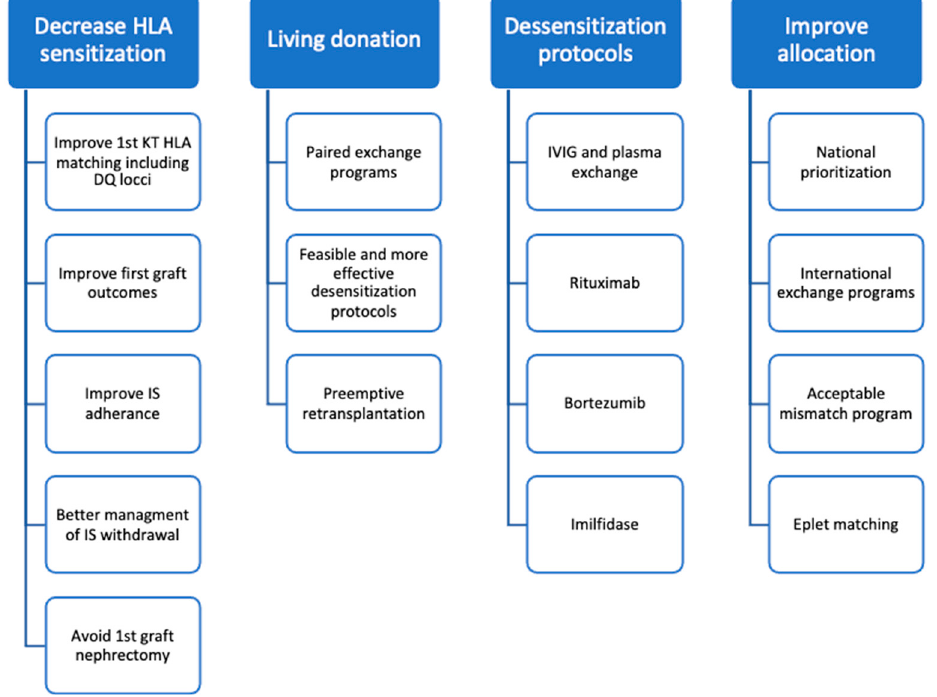
Figure 1. Strategies to increase retransplantation access. KT—kidney transplant; IS—immunosuppression.